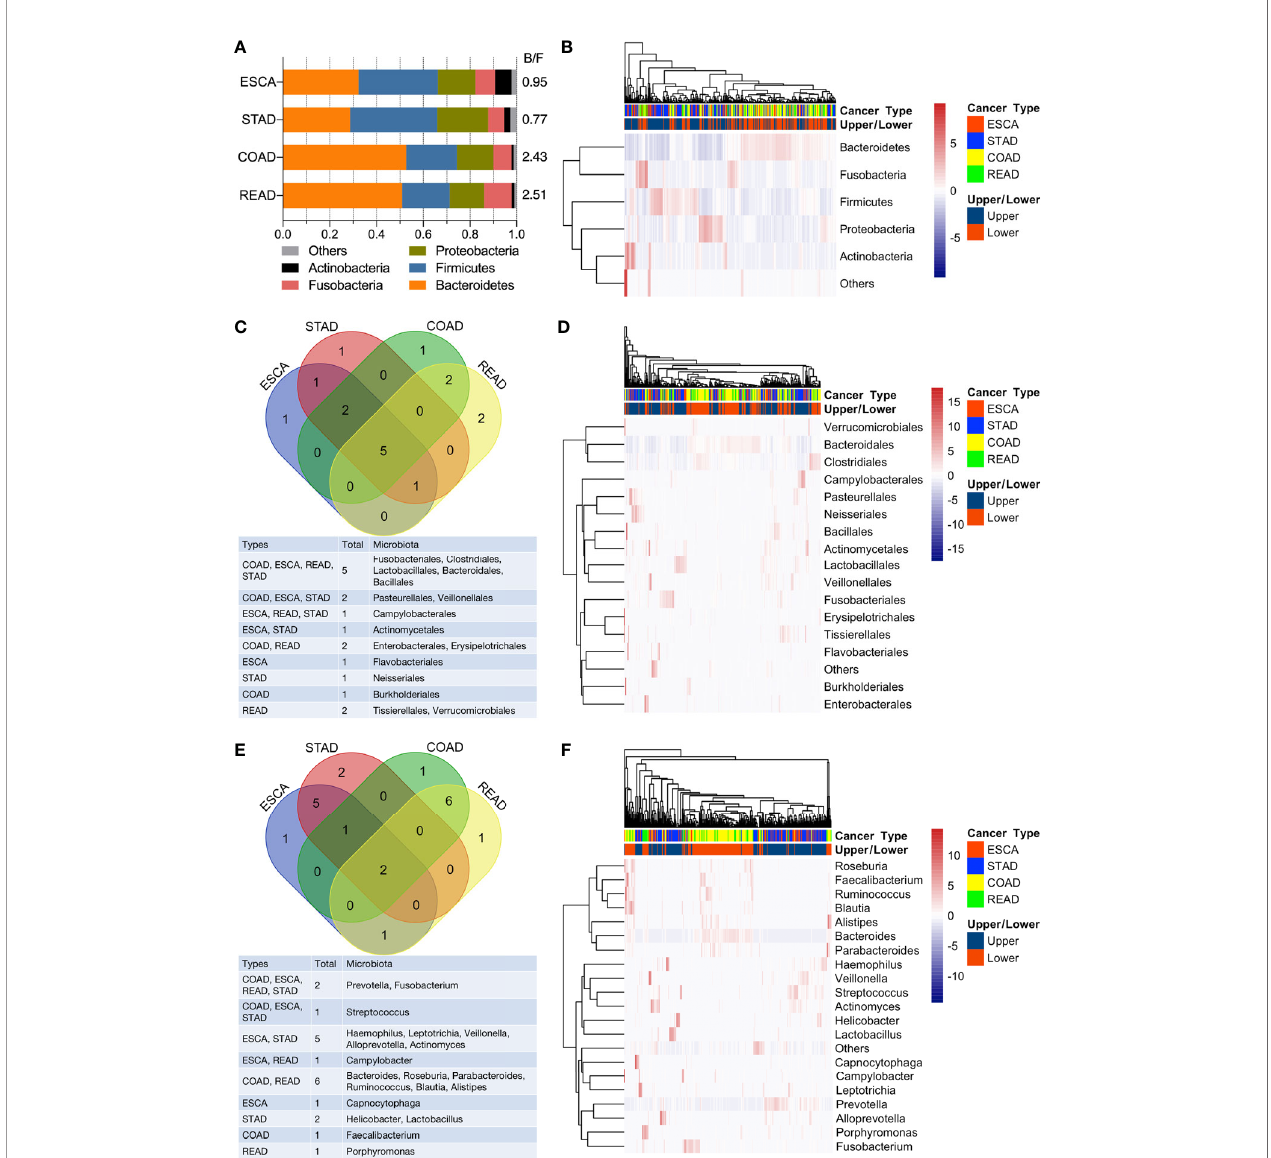
FIGURE 3 | Analysis of microbial abundance in GI cancers. (A) The top fi ve most abundant microbial phyla in the four cancer types; the B/F ratio represents the Bacteroidetes/Firmicutes ratio. (B) Bi-clustering heatmap based on the top fi ve abundant microbial pro fi les at the phylum level. The horizontal axis represents the samples, and the vertical axis represents the microbial taxa. (C) Venn diagram of the top 10 abundant microbial compositions at the order level. (D) Bi-clustering heatmap based on the top 10 abundant microbial pro fi les at the order level. (E) Venn diagram of the top 10 abundant microbial compositions at the genus level. (F) Bi-clustering heatmap based on the top 10 abundant microbial pro fi les at the genus